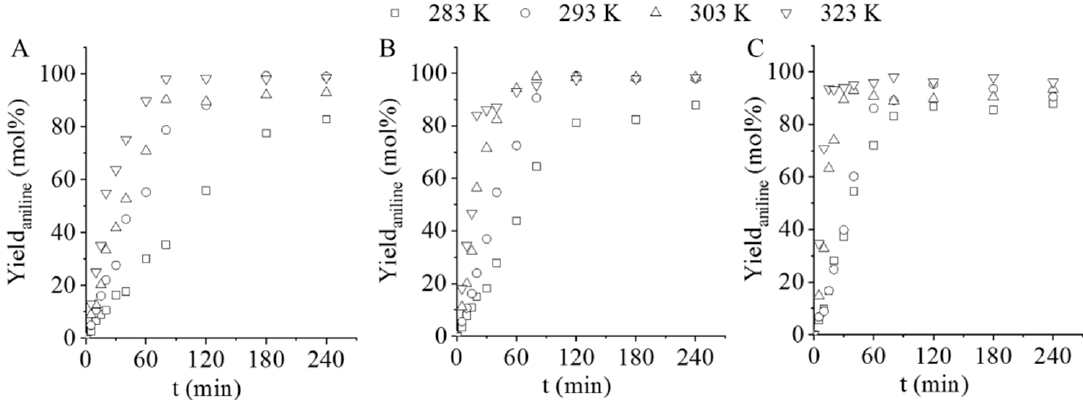
Figure 8. Aniline yield on the Pd/GCF ( A ), Pd/GCF-AC1 ( B ), and the Pd/GCF-AC2 ( C ) catalyst vs. time of hydrogenation. Table 4. Optimal synthesis parameters in case of each catalysts.